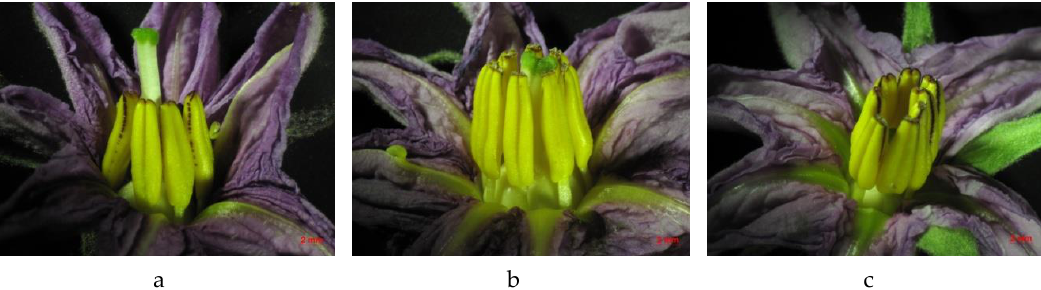
Figure 1. Stylar heteromorphism in eggplant: The flower with long-styled pistil of “Flavine” F 1 ( a ), medium-styled pistil of “Gascona” F 1 ( b ), short-styled pistil of “Epic” F 1 ( c ) .